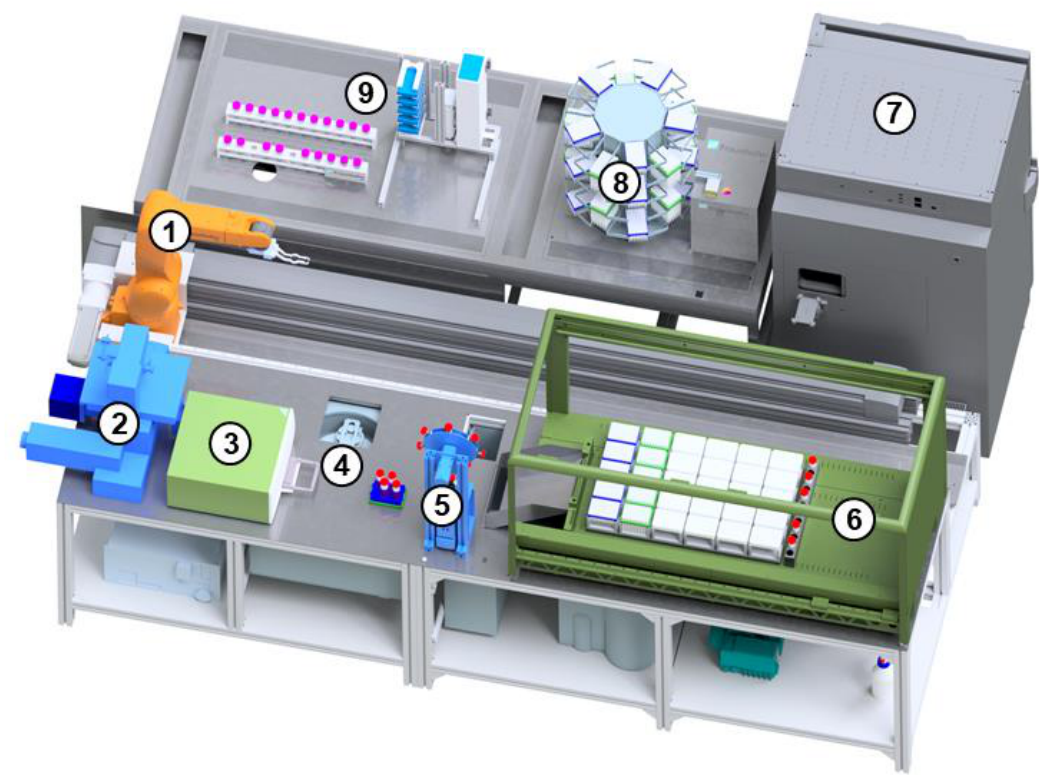
Figure 2. Visual representation of the StemCellDiscovery from the inside with ( 1 ) robot, ( 2 ) high-speed microscope, ( 3 ) plate reader, ( 4 ) centrifuge, ( 5 ) decapper, ( 6 ) liquid handling unit, ( 7 ) incubator, ( 8 ) storage for pipettes, ( 9 ) storage for tubes and plates. The cleanroom cabinet surrounding the system is not shown.